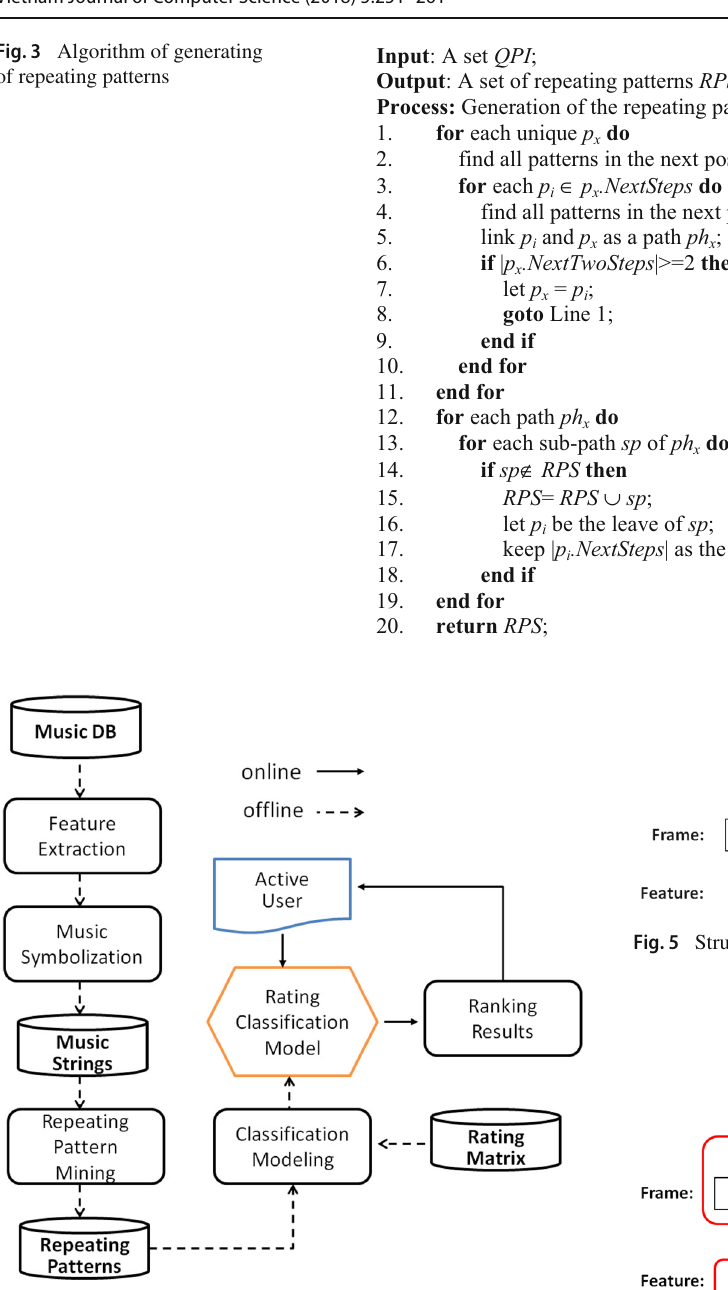
Fig. 4 Framework of the proposed music recommender system